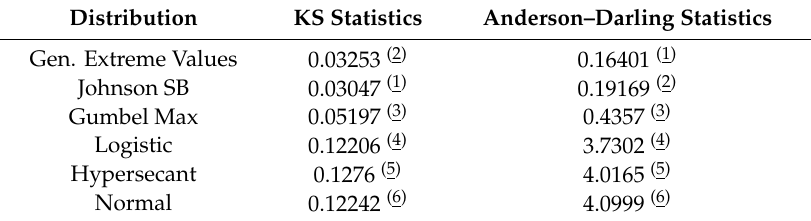
Table 4. Best probability distribution with Kolmogorov–Smirnov (KS) and Anderson–Darling statistics, ranking the best from top to bottom. Superscript in red indicates the rank of the KS and Anderson–Darling statistics.